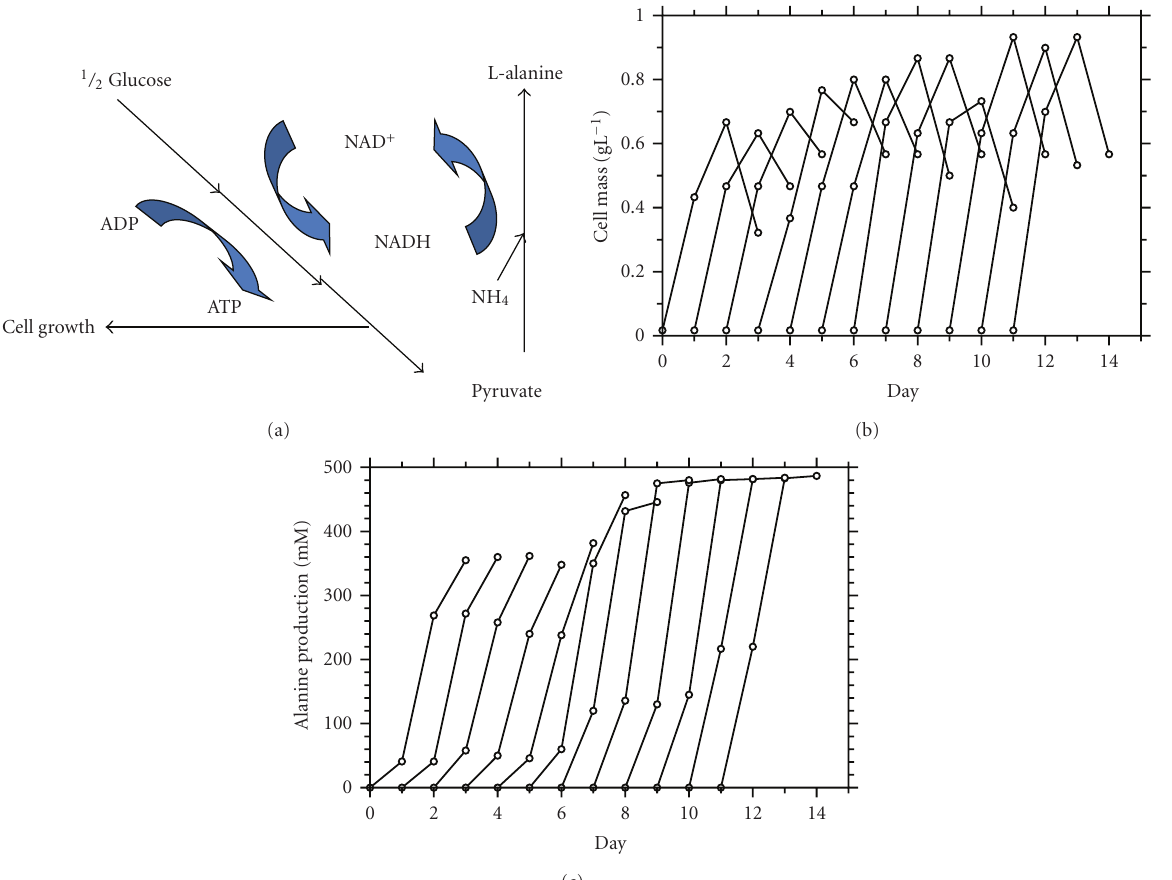
Figure 3: Metabolic evolution for improving L-alanine production in E. coli [27]. 3(a) Redesigned metabolic pathway for L-alanine production: ATP production and cell growth is coupled to NADH oxidation and L-alanine production. 3(b) Directed evolution improves cell growth. Parental strain XZ112 reaches a maximum cell mass of 0.7gL − 1 after 48 hours of fermentation; evolved strain XZ113 attains 0.7gL − 1 after 24 hours and a maximum of 0.9gL − 1 after 48 hours; 3(c) metabolic evolution to improve cell growth also improves alanine production. Parental strain XZ112 produces 355 mM alanine after 72 hours of fermentation; evolved strain XZ113 produces 484mM in 48